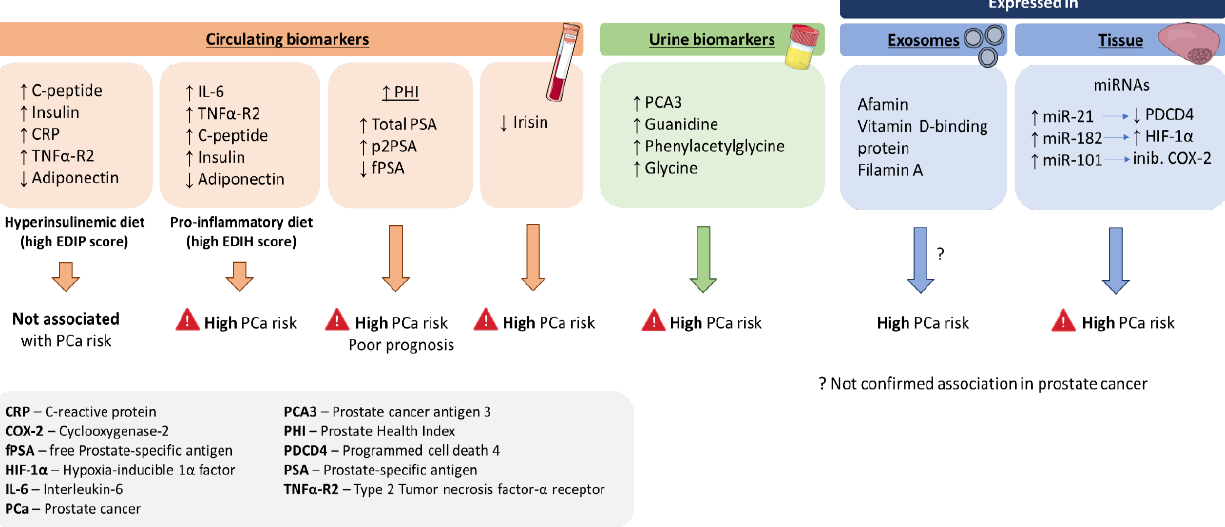
Figure 1. Possible novel biomarkers linked with PCa research and their association with PCa risk.